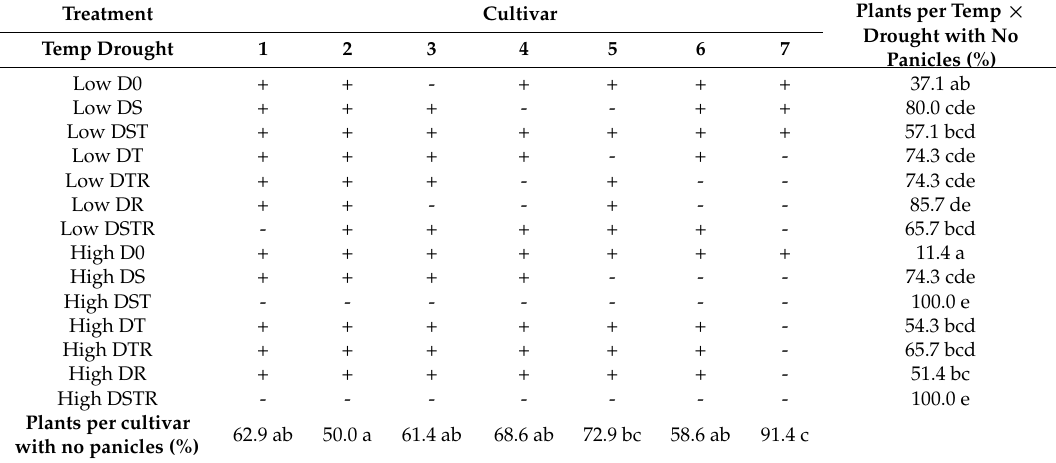
with no panicles (%) Means followed by the same letters within a column for treatment or within a row for cultivar are not significantly different at p < 0.05 according to Tukey’s mean comparison test.